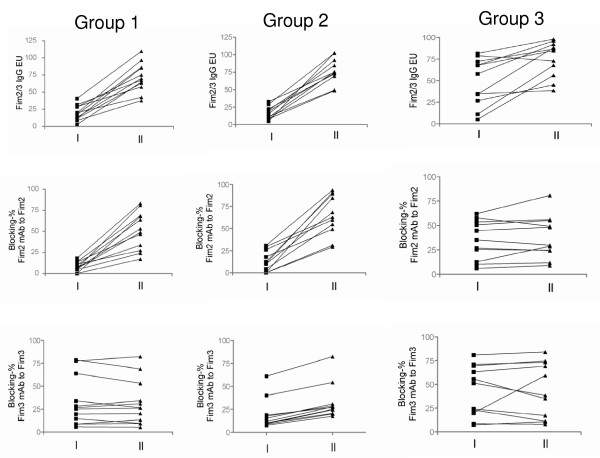
Detection of epitope-specific antibody responses to fimbriae in paired sera from Fim2 infected patients. Group 1 included 12 patients who had significant increases in level of IgG antibodies to fimbriae and in blocking level of mAbFim2 to S1(Fim2) between paired sera (p < 0.01) but had no change in blocking level of mAbFim3 to S3. Group 2 consisted of 11 patients who had significant increases in level of IgG antibodies to fimbriae and in blocking levels of both mAbFim2 to S1(Fim2) and mAbFim3 to S3(Fim3) between paired sera (p < 0.01 for both). Group 3 included 11 patients who had no change either in level of IgG antibodies to fimbriae or in blocking levels of both mAbFim2 to S1(Fim2) and mAbFim3 to S3(Fim3) between paired sera.